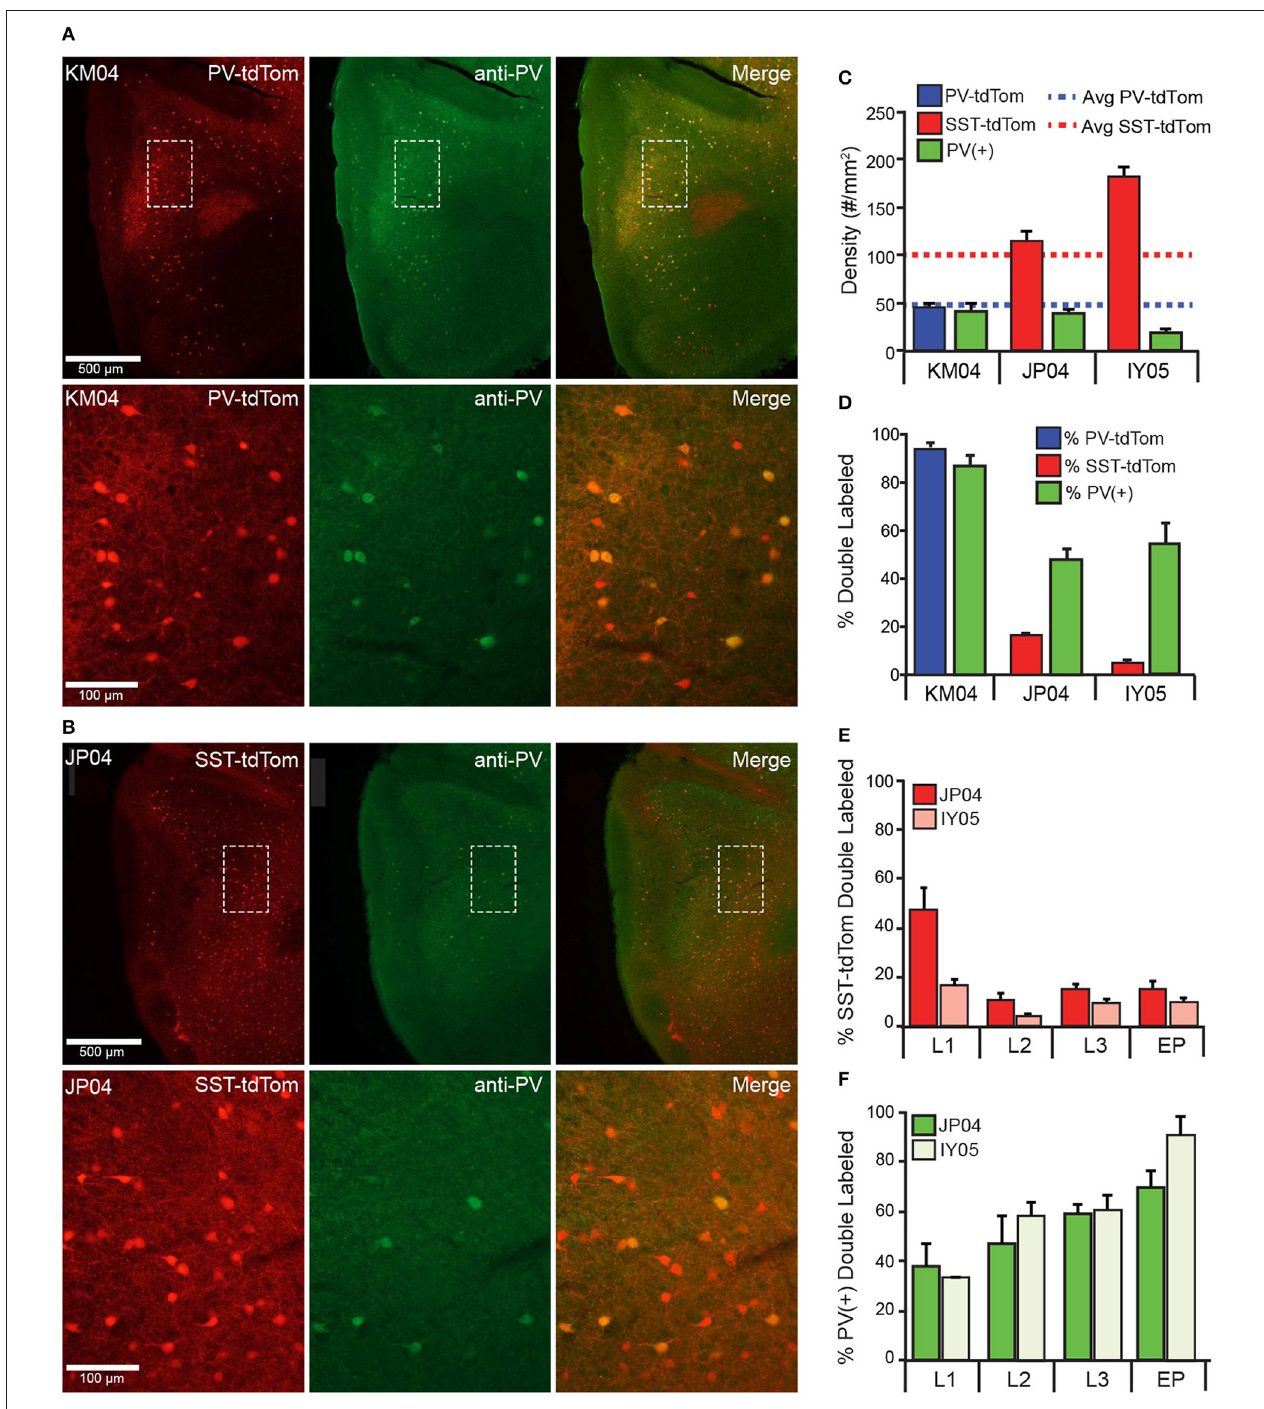
FIGURE 4 | Co-expression of parvalbumin and tdTomato in PV-Cre and SST-Cre lines. Anti-parvalbumin immunostaining in (A) PV-tdTom mouse (KM04) and (B) SST-tdTom mouse (JP04). Sections from both animals were stained in the same experiment. Upper panels show the APC (4x magnification), lower panels show area indicated by dashed box at higher magnification (20x) Left panels: tdTom( + ) neurons (red) in the PV-tdTom (A) or SST-tdTom (B) animals; middle panels: PV( + ) interneurons labeled with GFP (green); and right panels: co-expression tdTom( + ) and PV( + ) cells (yellow). (C) Density of tdTom( + ) cells in the PV-tdTom (KM04, blue) and two SST-tdTom (JP04, red; IY05, pink) mice. Dashed lines correspond to average densities of tdTom( + ) cells reported for all SST-tdTom (red) and PV-tdTom (blue) mice. The green bars correspond to the density of PV( + ) cells in each mouse. (D) Co-expression of PV( + ) and tdTom( + ) as a percentage of tdTom( + ) cells in PV-tdTom (blue) or SST-tdTom (red) mice or as a percentage of PV( + ) cells (green) in each mouse. (E) Co-expression of PV( + ) and tdTom( + ) as a percentage of tdTom( + ) cells in SST-tdTom mice (JP04 red, IY05 pink) by layer. (F) Co-expression of PV( + ) and tdTom( + ) as a percentage of PV( + ) cells in SST-tdTom tissue (JP04 dark green, IY05 light green) by